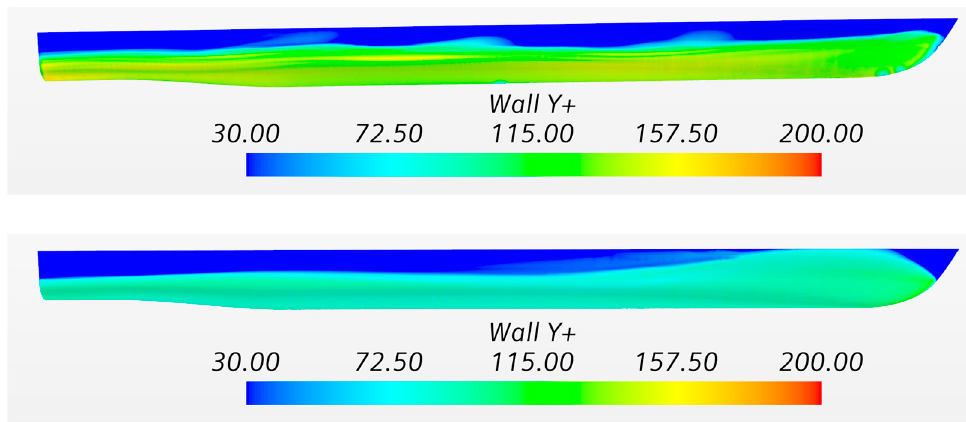
Figure 4. Computed y + distribution on the demihull surface at Fn = 0.287 ( upper ) and 0.805 ( below ) in shallow water.